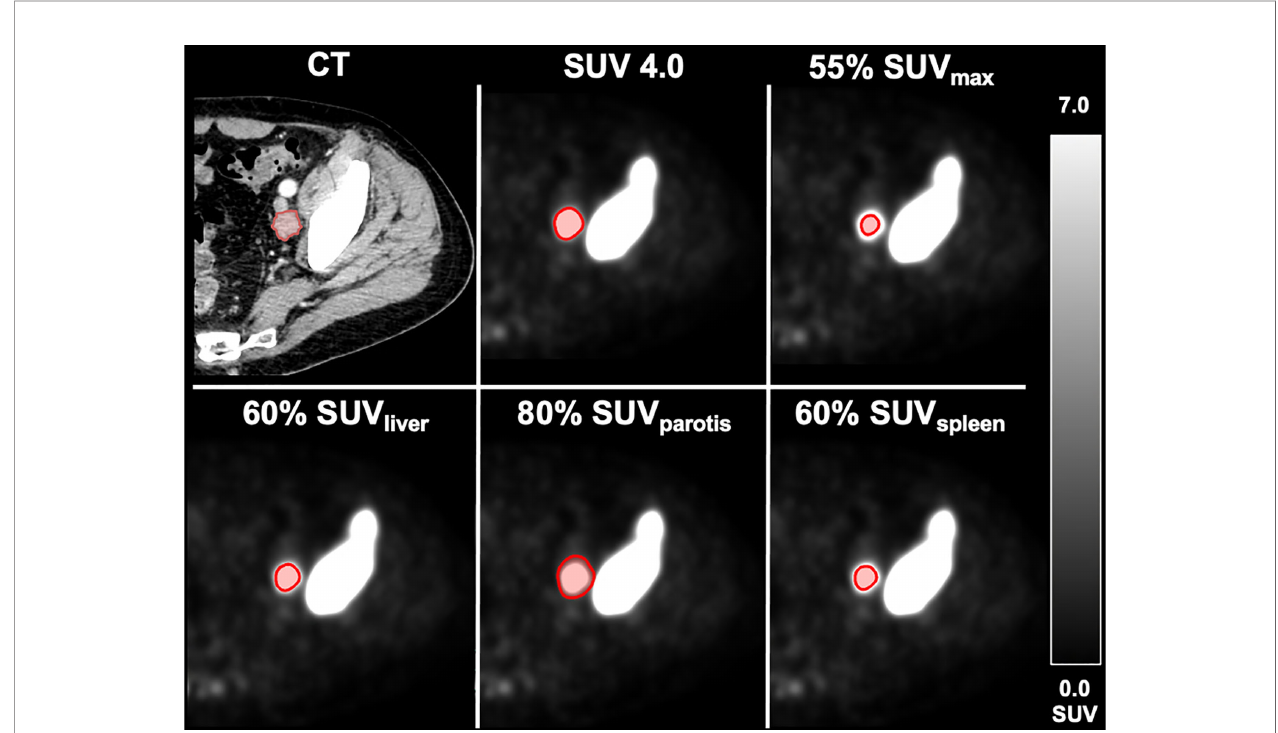
FIGURE 1 | Different delineation methods in an exemplary metastatic patient. Volumetric reference standard 6.3 m; SUV 4.0: 5.5 ml. 55% SUV max : 1.0 ml. 60% SUV